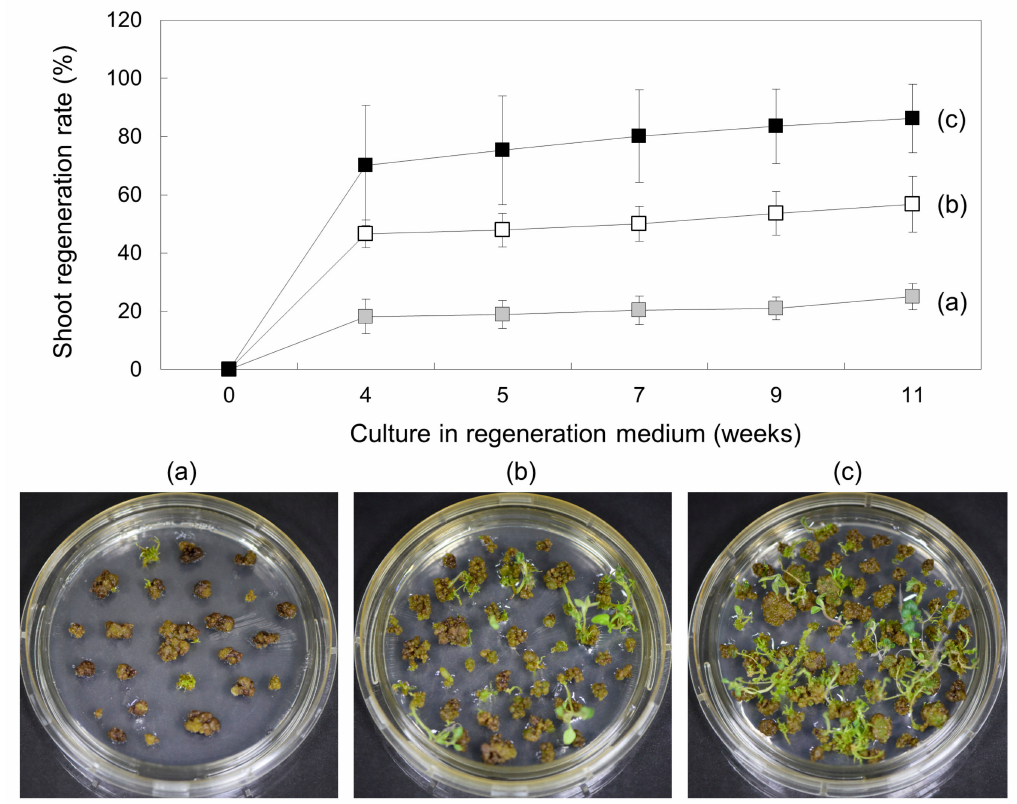
Figure 7. Effects of culture period on callus greening in G medium. Proliferated minicalli in P medium were cultured in G medium for 4 weeks ( , ( a )), 5 weeks ( , ( b )), and 6 weeks ( , ( c )) and then transferred to SI2 medium for shoot induction. Regeneration efficiency was measured using an average of 60 calli clumps per replicate. Three to five replicates were averaged. Error bars indicate ± standard deviation of the mean